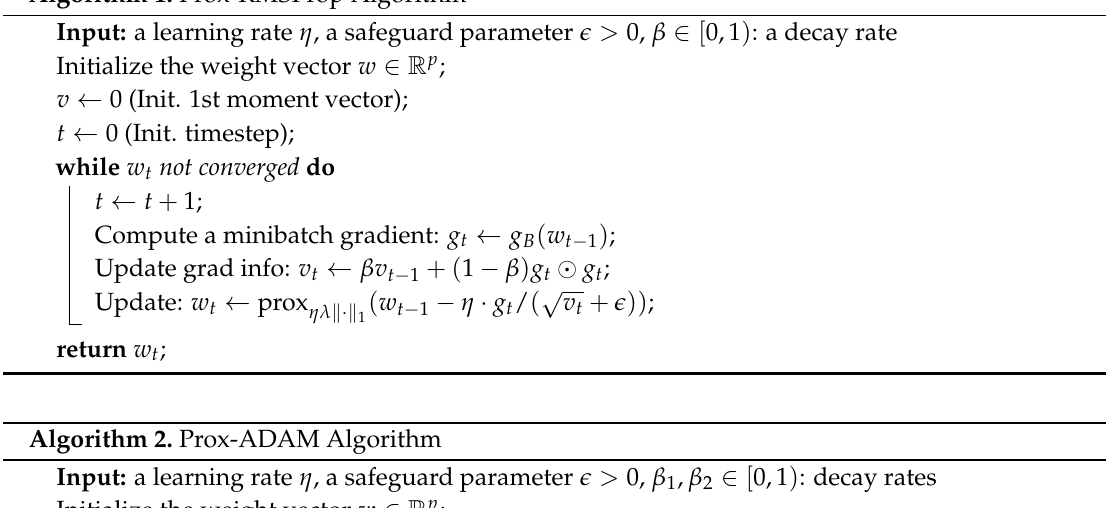
Algorithm 1. Prox-RMSProp Algorithm